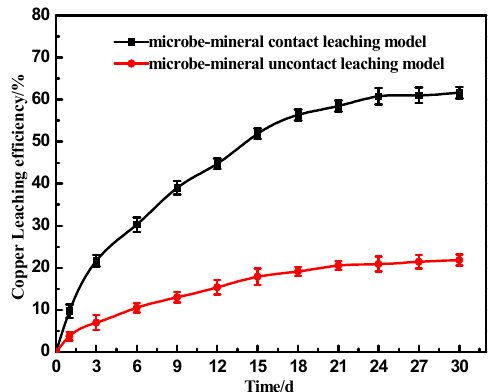
Figure 5. Copper leaching efficiency with bioleaching time.